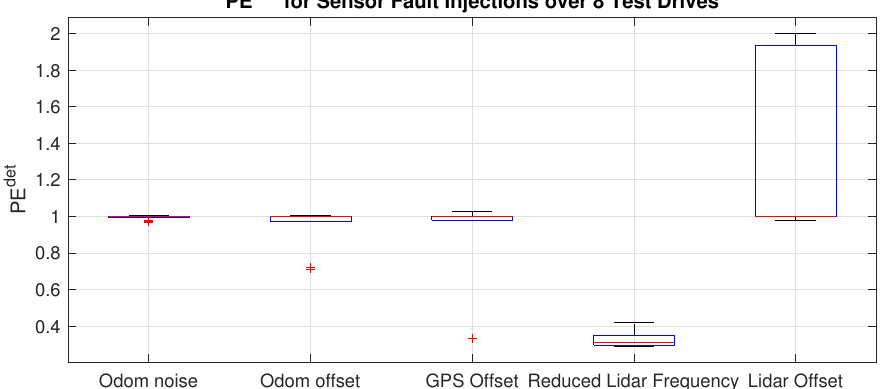
Figure 7. Distribution of perturbation errors per detection perturbation type.